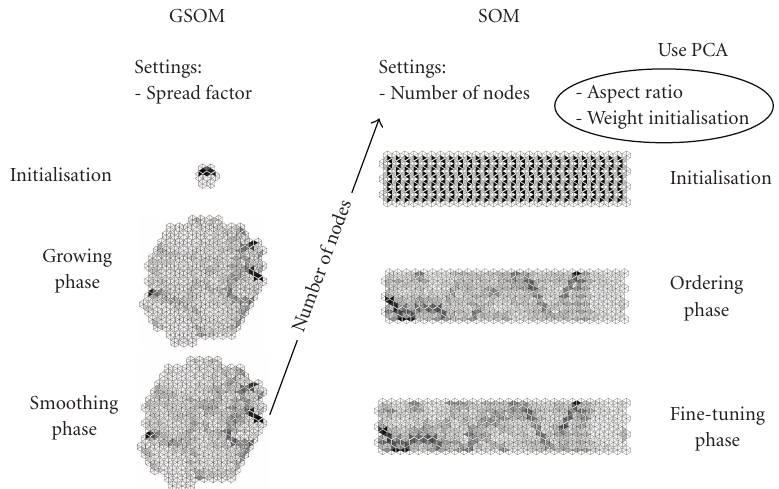
Figure 4: Illustration of method used to compare SOM and GSOM.